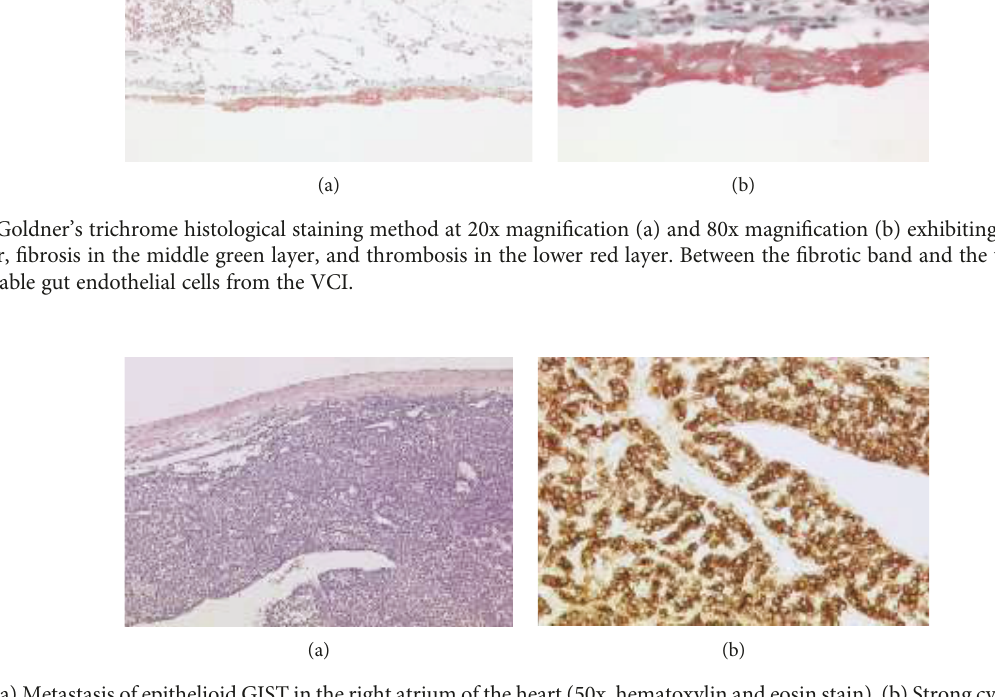
Figure 7: (a) Metastasis of epithelioid GIST in the right atrium of the heart (50x, hematoxylin and eosin stain). (b) Strong cytoplasmic pattern of KIT immunostaining in epithelioid GIST in the right atrium of the heart (200x, CD117 antibody).